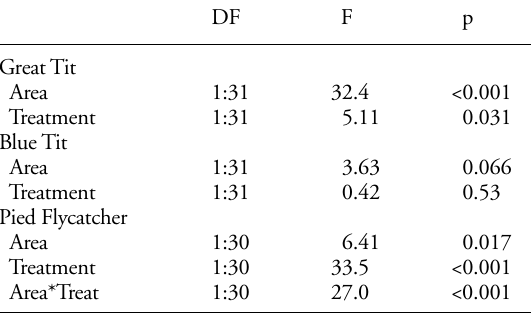
Table 2. Experimental study. ANCOVA test of treatment and patch area effects on the change from 1983 to 1984 in number of territories. Both patch area and change were log transformed before analysis. For the tits, the interactions were not significant and removed before the final